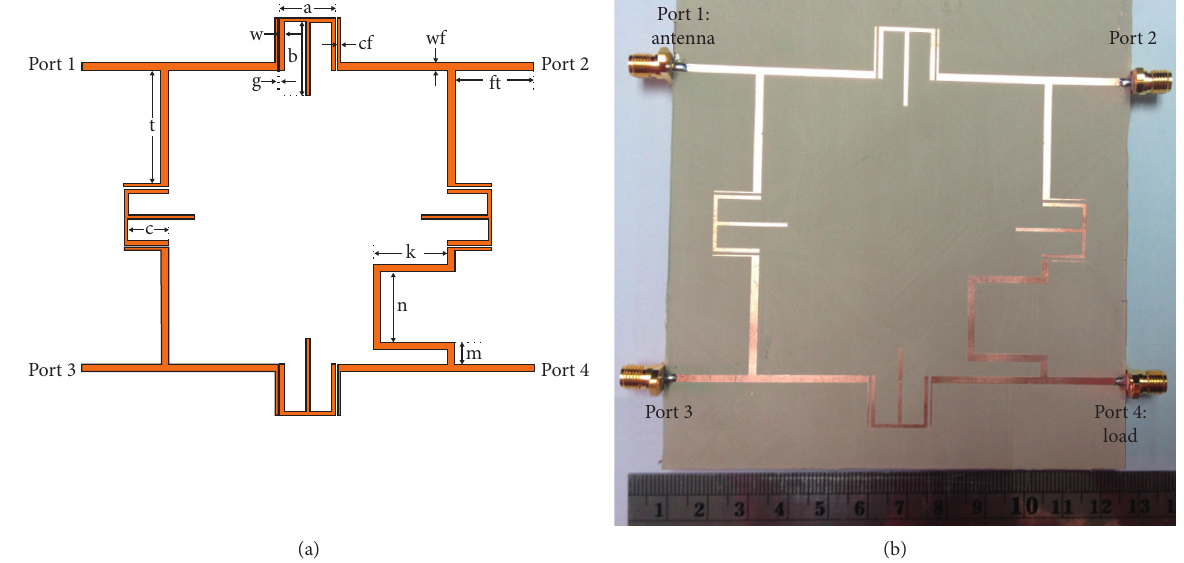
Figure 6: (a) Layout. (b) Photograph of four-port dual-mode diplexer. Table 1: Dimensions of four-port microstrip dual-mode resonator diplexer.